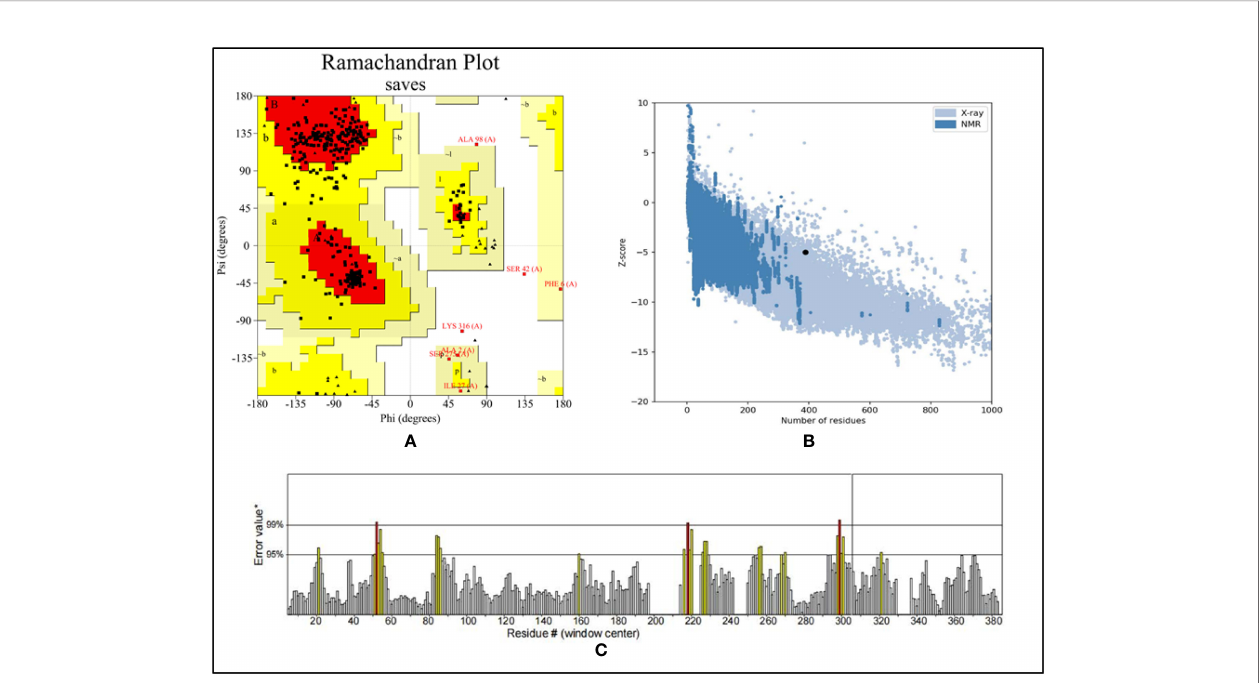
FIGURE 3 | (A) Ramachandran plot of the vaccine. Red denotes the most favored region, dark yellow denotes the additional allowed region, light yellow denotes the generally allowed region, and white denotes the disallowed region; (B) three dimensional (3D) structure of the vaccine was validated by ProSA with a Z score of -5.01; (C) 3D structure of the vaccine was validated by ERRAT with an ERRAT score of